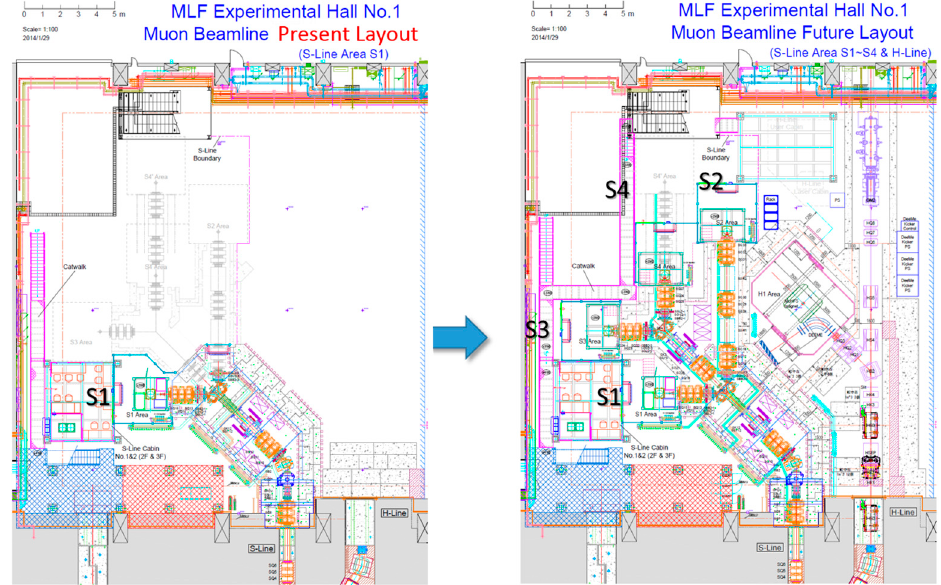
Figure 9. Current layout of the S-line to experimental area S1 ( left ) and a provisional floor plan for the completed S-line complex with four branches, one to each of the experimental areas ( right ). The cross-hatched areas near the shielding wall to the M1/M2 tunnel indicate the power supply yards.